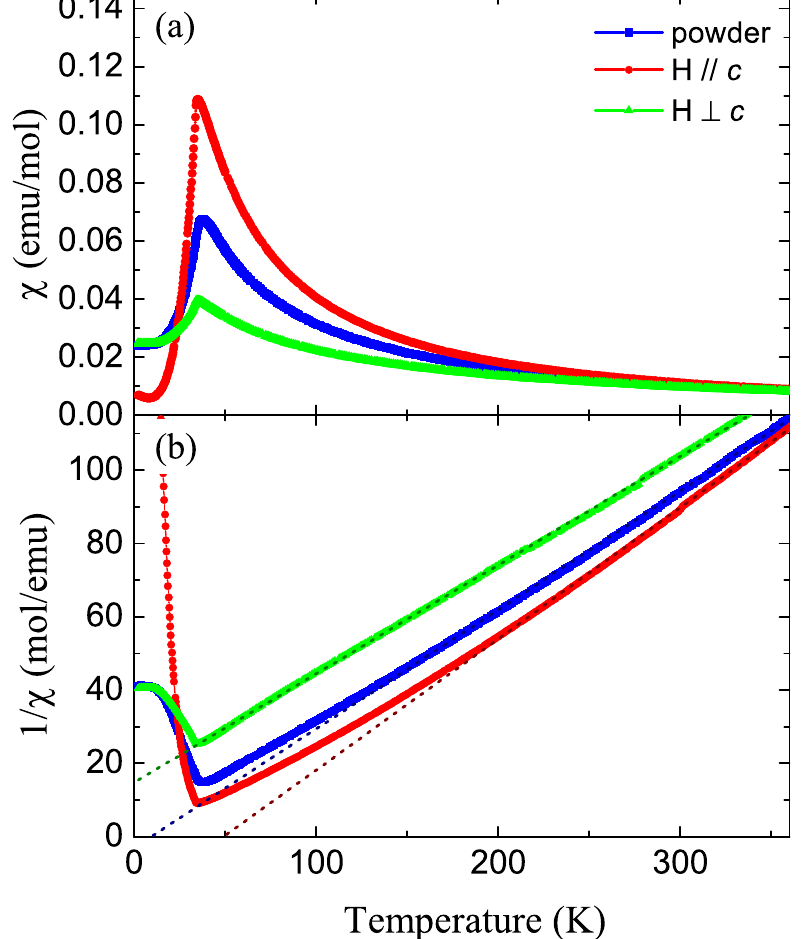
Figure 5. ( a ) Direction dependent magnetic susceptibility ( χ ) of CoGeO 3 single crystals measured in a field of µ 0 H = 0.1 T. For comparison also the values for a CoGeO 3 powder sample are shown. ( b ) The inverse of the magnetic susceptibility ( χ − 1